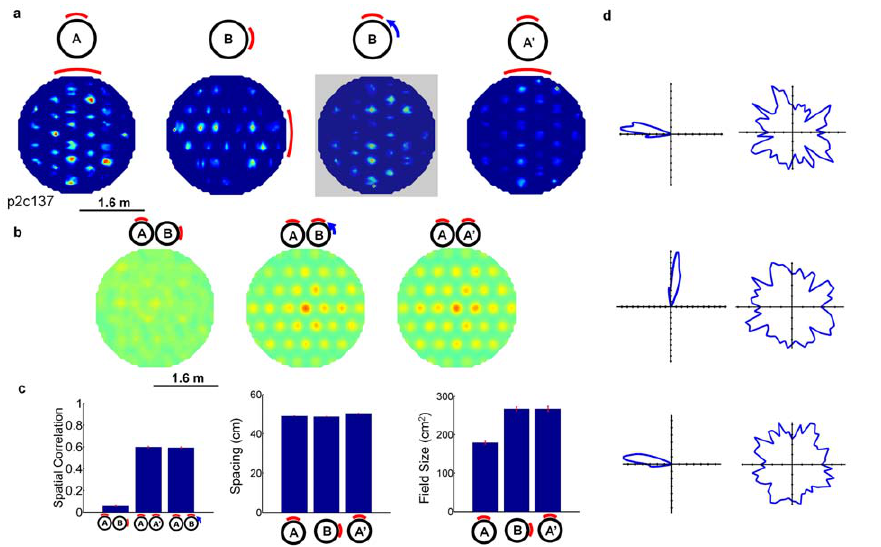
Figure 5. Firing fields under cue rotation, and in a second experiment with the original cue configuration. (a) Firing fields before and after rotation are seemingly unrelated, but become correlated if the B firing field is rotated 90 degrees counter-clockwise. (b) Cross-correlation plots corresponding to fields shown in (a). (c) Spatial correlation, field spacing and size for the different cue configurations (means 6 s.e.m.). (d) The directional tuning of a specific cell rotated 90 u after the cue rotation, and rotated back in a second experiment with the original cue configuration (left), and the duration of time spent at each head direction (right).